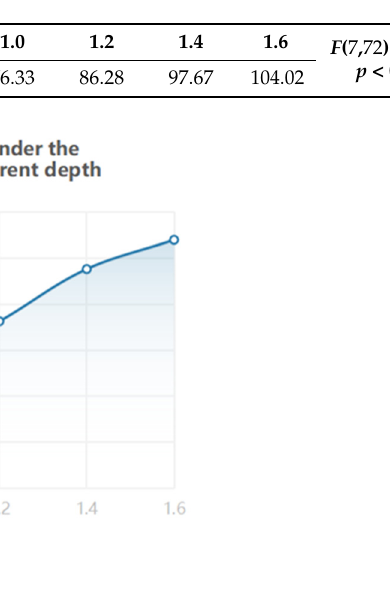
Figure 5. Operation process diagram in the depth distance experiment of manipulating interactive information (( a ) Change the position of the target. ( b ) Change the color of the target). The collected task completion time and eye movement data were analyzed [41,42].